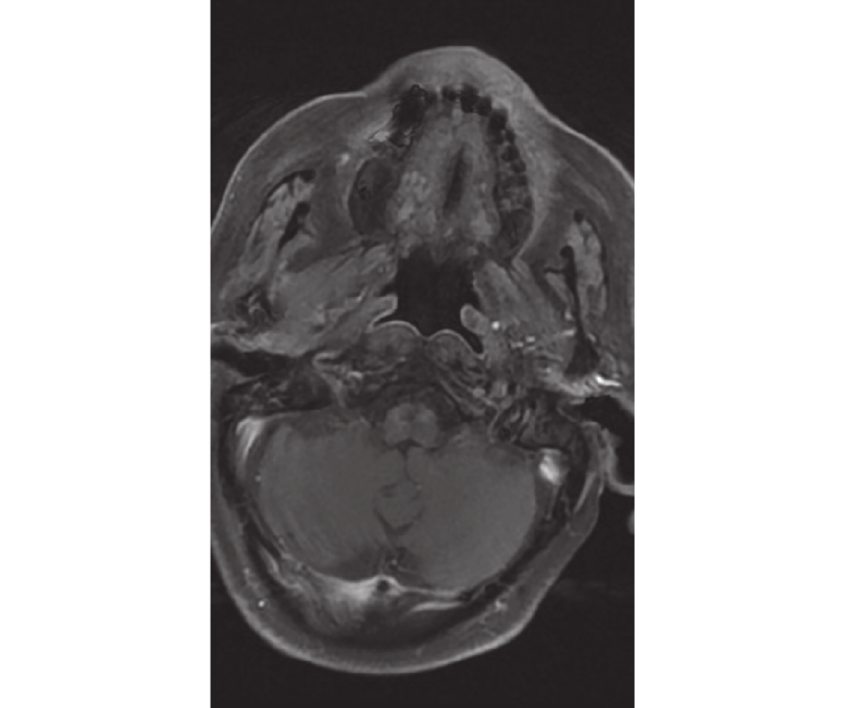
Figure 5: T1-weighted axial MRI slice showing abnormal soft tissue enhancement gradually resolved following six weeks of